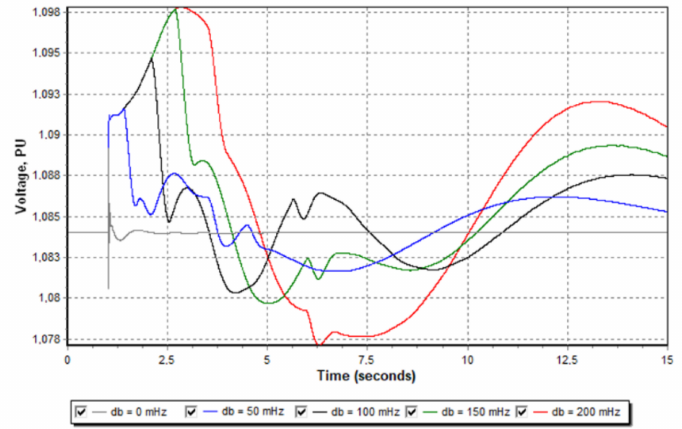
Figure 25. Voltage fluctuations on the 330 kV side.